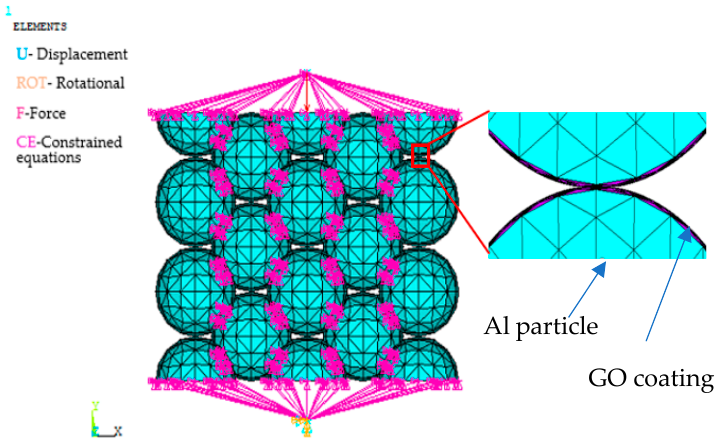
Figure 1. Schematic representation of finite element (FE) model of GO/Al composite.